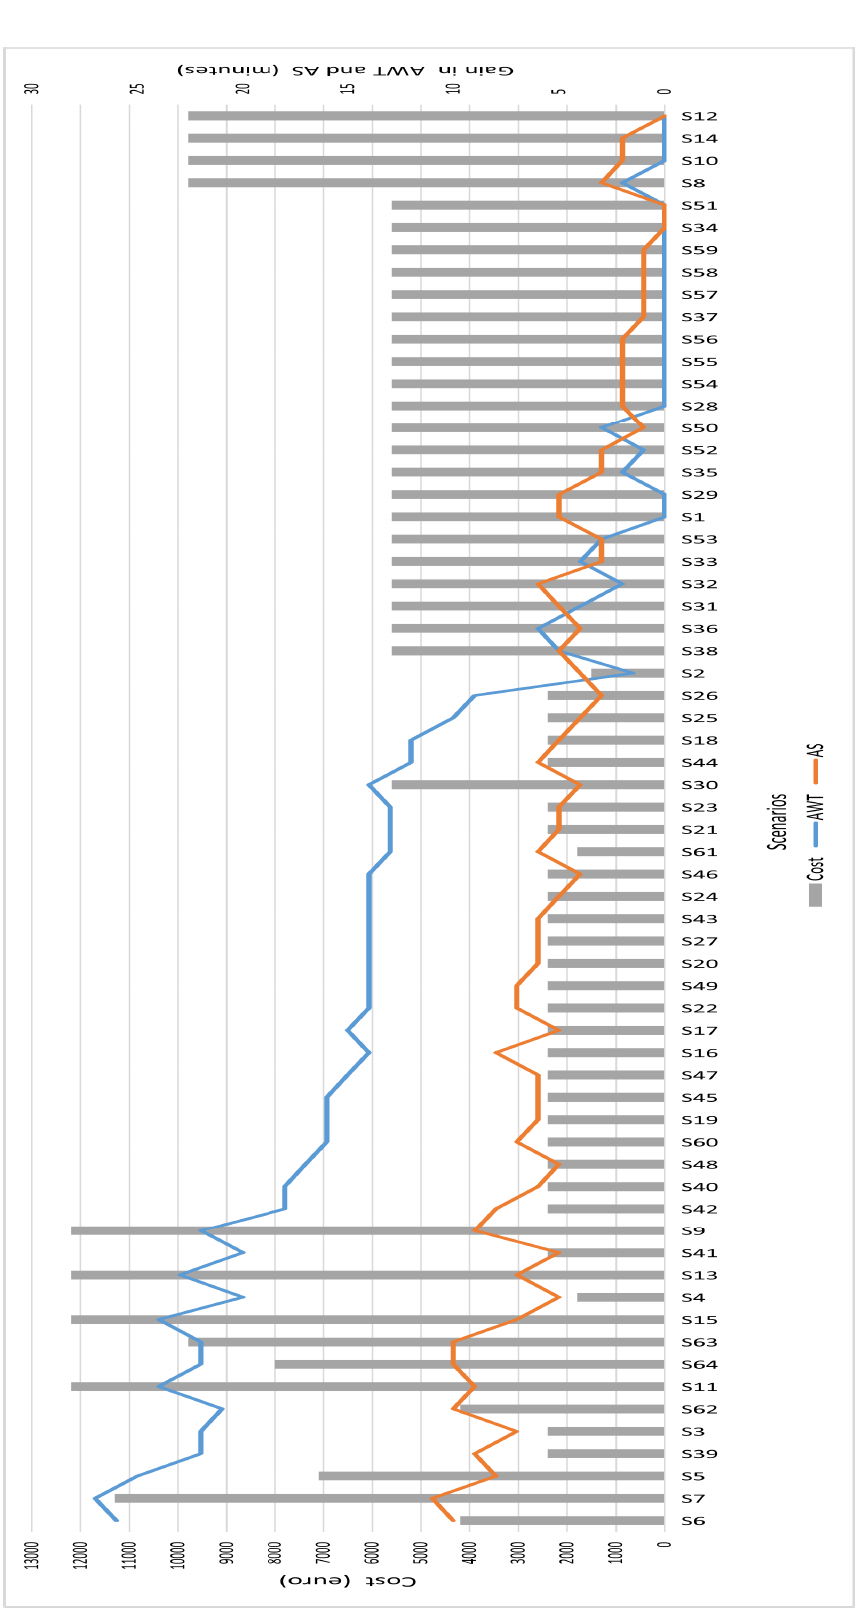
Figure 6. Result of the classification of the scenarios for Category 1 (resource-related—flexible staff and shifts, short